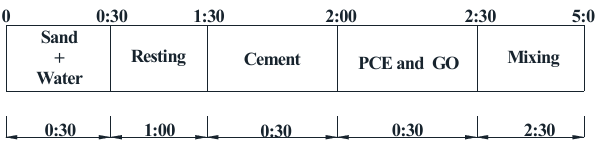
Figure 2. Mixing sequence of RFA mortar (unit: min).